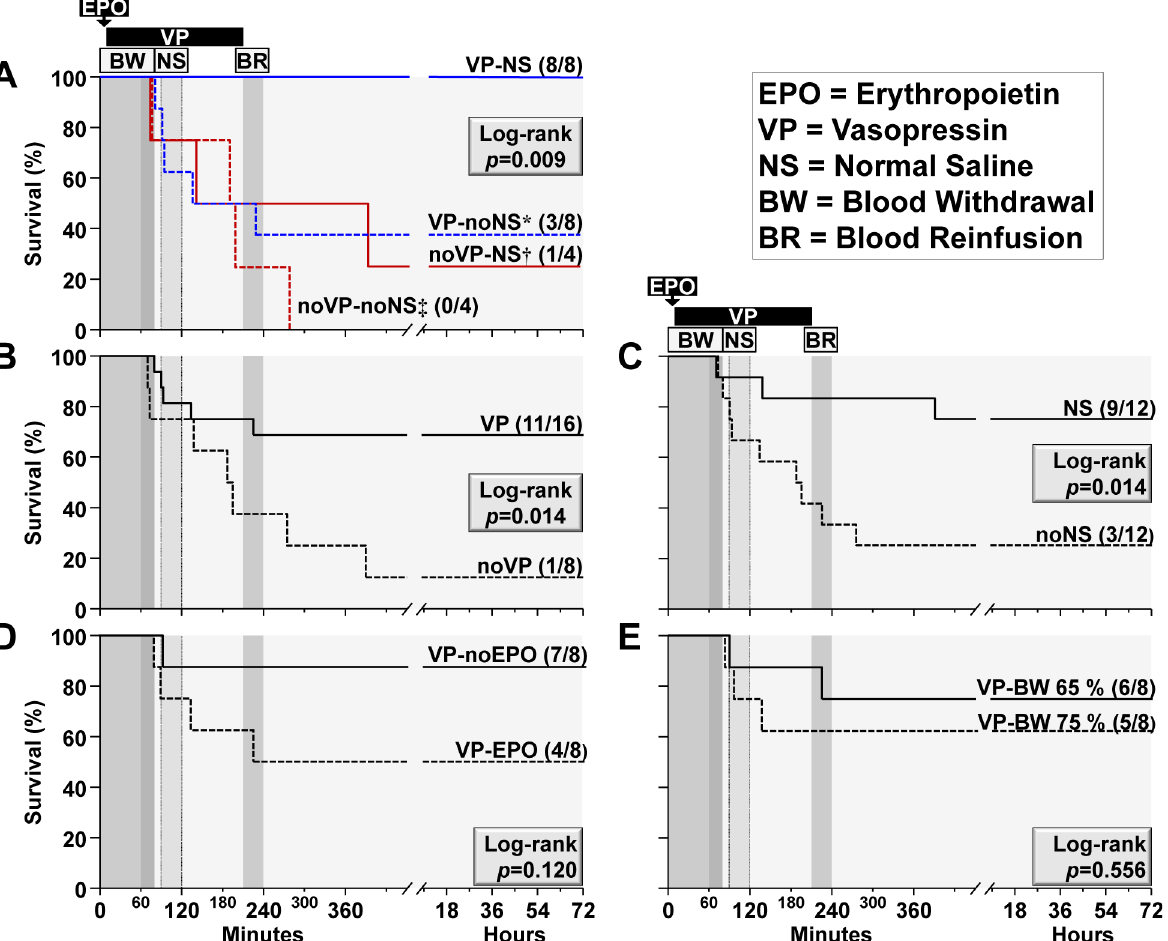
Fig 2. Survival analysis. Kaplan-Meier survival curves analyzed using the log-rank test and the Holm-Sidak test for multiple comparisons when applicable. The p -value for each log-rank test results is shown inside each graph. ( A ) Kaplan-Maier survival curves comparing the effects of vasopressin with normal saline (VP-NS), VP without NS (VP-noVP), no VP with NS (noVP-NS), and neither VP nor NS (noVP-noNS). Pairwise comparisons by the Holm-Sidak test demonstrated significantly lower survival for VP-noNS ( * p = 0.035), noVP-NS ( † p = 0.0198), and noVP-noNS ( ‡ p = 0.001) compared with VP-NS. B through E show Kaplan-Maier survival curves for the independent effects of vasopressin ( B ), normal saline ( C ), erythropoietin ( D ), and hemorrhagic shock severity ( E ) with the remaining factors allocated as shown in Fig 1. In parentheses, number of animals alive at 72 hour survival relative to the initial subset.